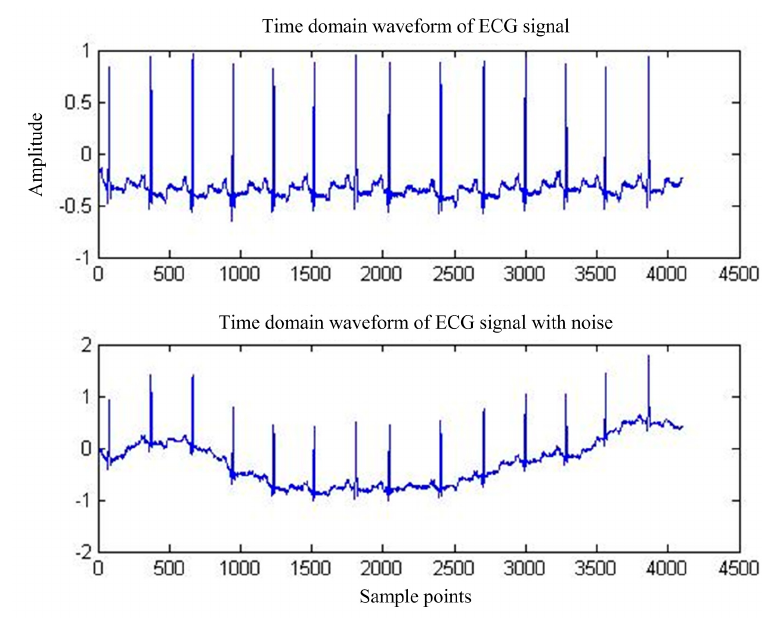
Figure 13. MIT-BIH ECG waveform before and after BW.